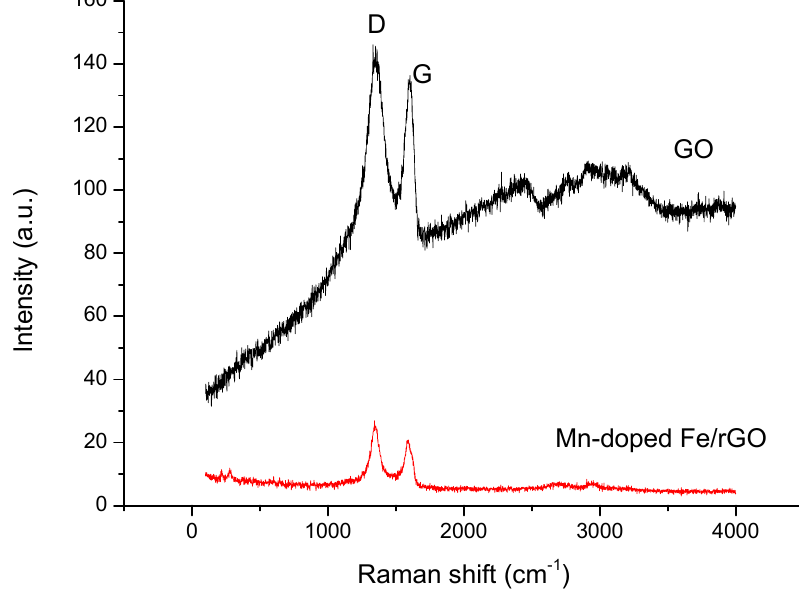
Figure 7. Raman spectra of GO and Mn-doped Fe/rGO.